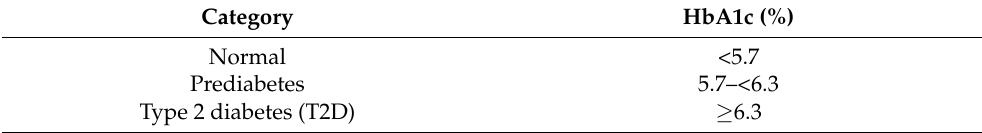
Table 2. Diagnostic values for prediabetes and type 2 diabetes (T2D) based on HbA1c